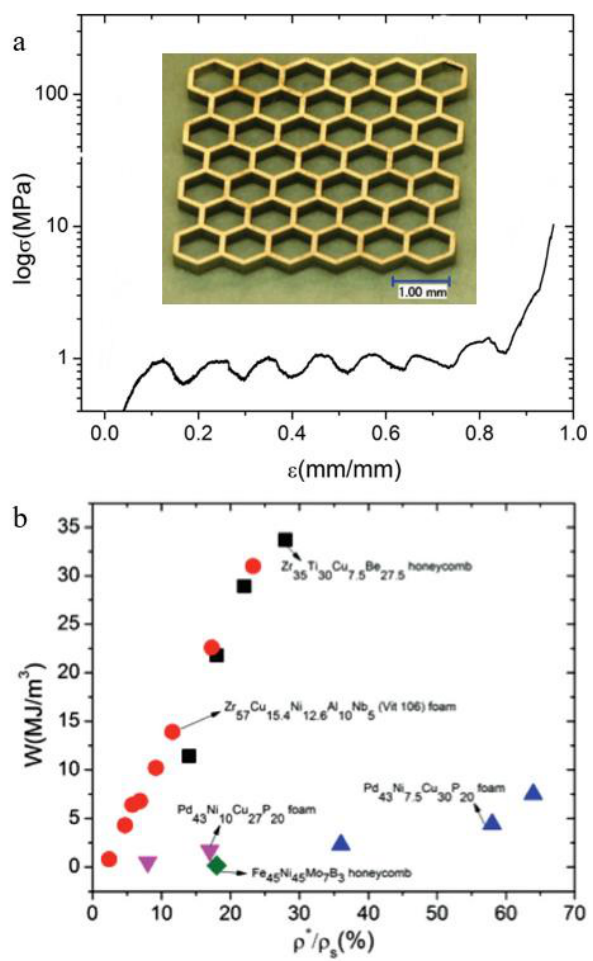
Figure 3. ( a ) The stress – strain curve of an MG honeycomb with ligament length/thickness ratio of 50, where the inset image shows an MG honeycomb with 39 cells. ( b ) The comparison of the plastic-energy-absorption performance of the Zr 35 Ti 30 Cu 7.5 Be 27.5 MG honeycombs and other cellular MG structures. Adapted from [9] with copyright permission from Wiley, 2012.